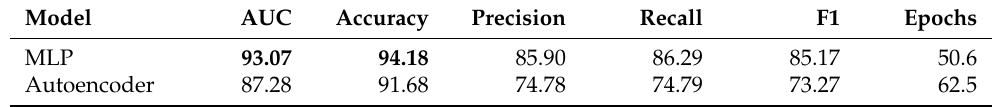
Table 6. DNN classification results per model. Bold highlights best